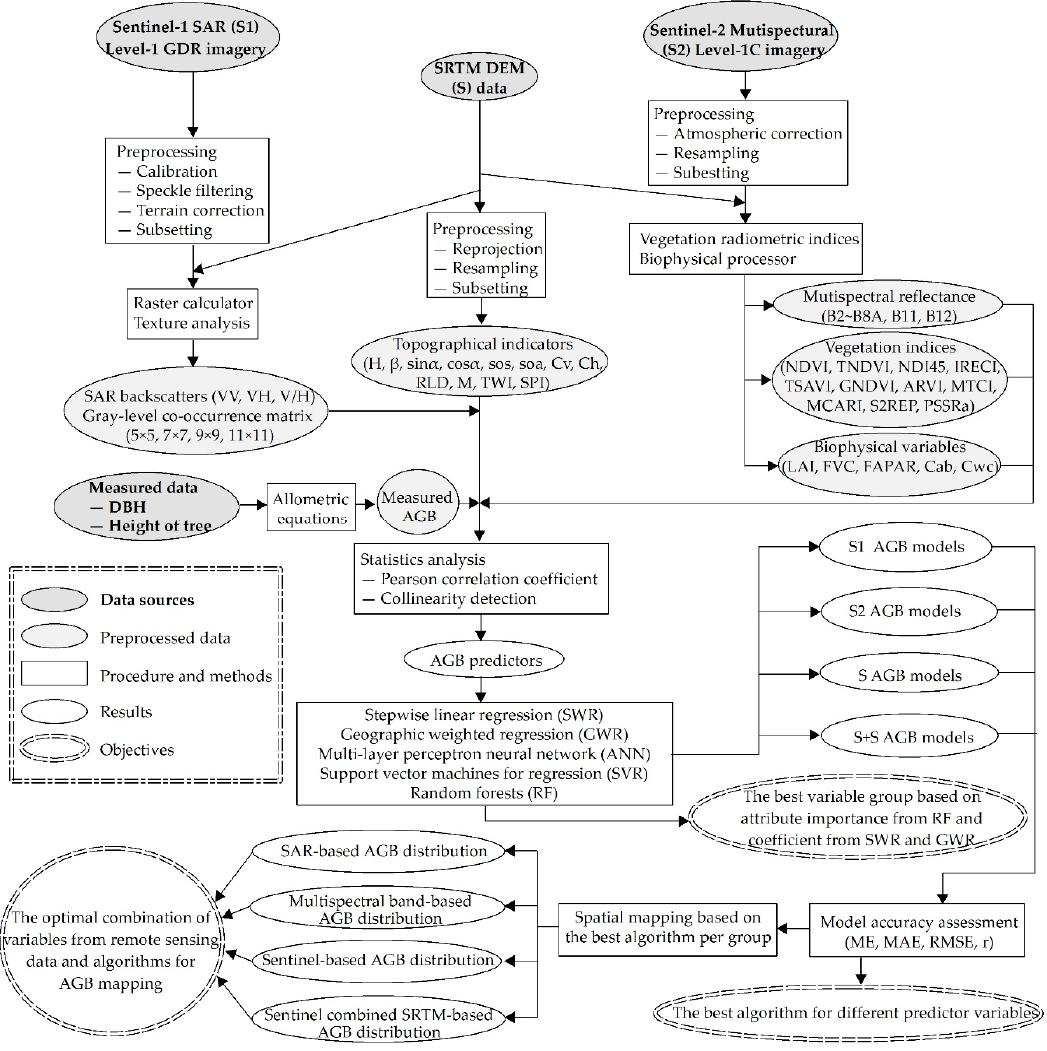
Figure 3. Flowchart for the evaluation of the optimal combination of predictors, and modeling algorithms for forest above-ground biomass mapping from Sentinels and the SRTM data.